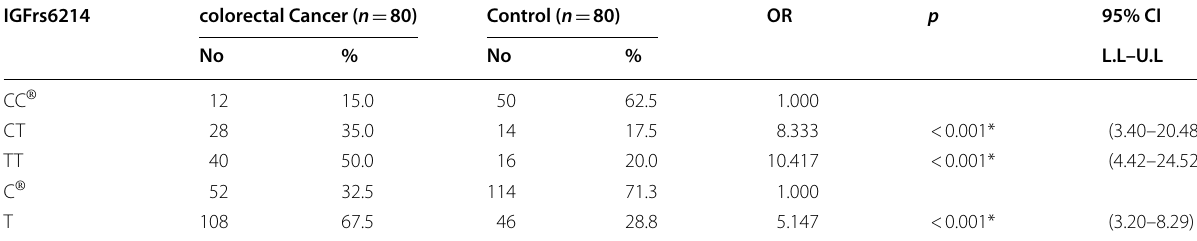
Table 3 Odds ratio of different genotypes and alleles of IGF-1 rs6214(C/T) polymorphism